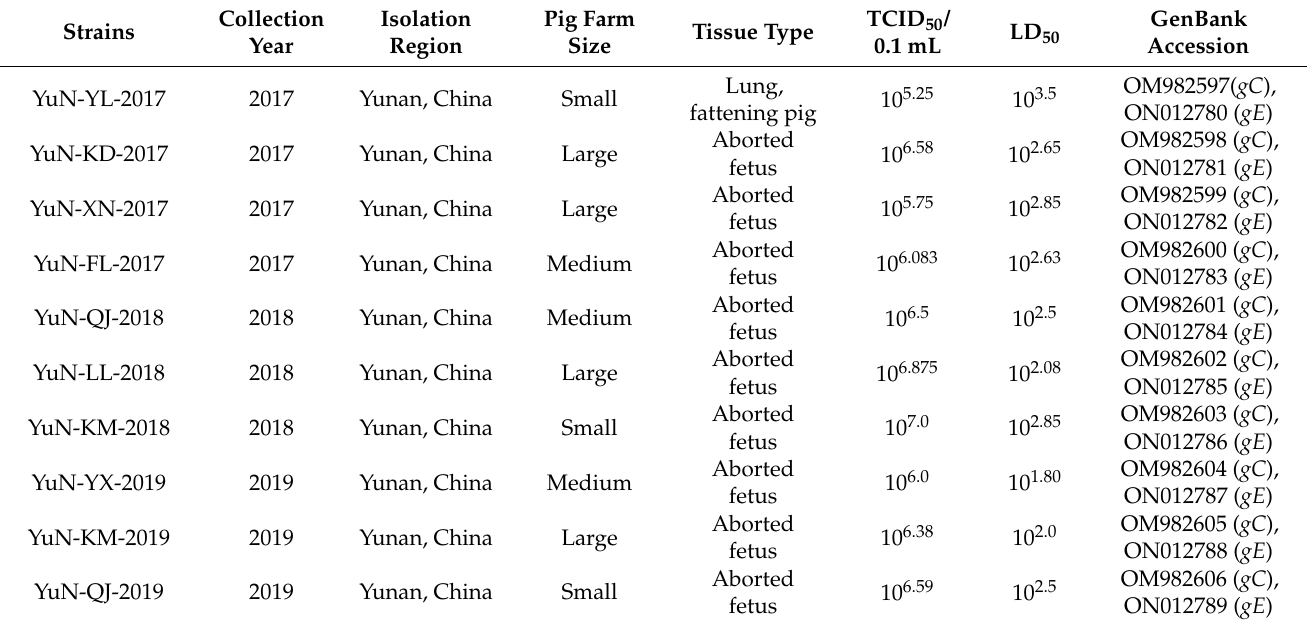
Table 1. Detailed information of PRV strains identified in this study and reference strains, including GenBank accession